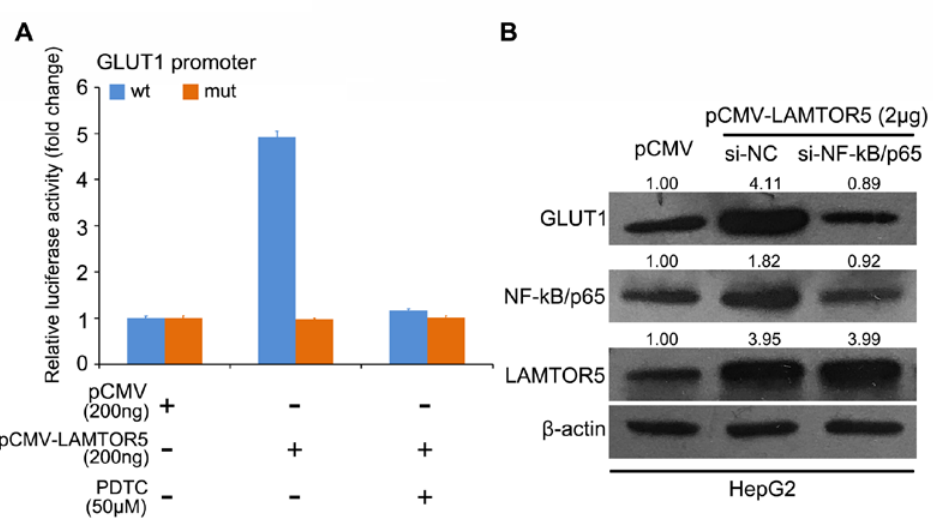
Figure 3: LAMTOR5 upregulates NF-κB to promote the transcription of GLUT1 in liver cancer. (A) The effect of LAMTOR5 and/or NF-κB inhibi- tor (PDTC) on wild type (wt) and mutant (mut) GLUT1 promoter was evaluated. (B) The level of NF-κB and GLUT1 in liver cancer cells under the administration of LAMTOR5 overexpression and/or NF-κB/p65 siRNAs was evaluated through Western blotting. ImageQuant 5.2 software (GE Healthcare, UK) was used to quantify the bands of GLUT1, NF-κB or LAMTOR5 relative to β-actin. ***P <